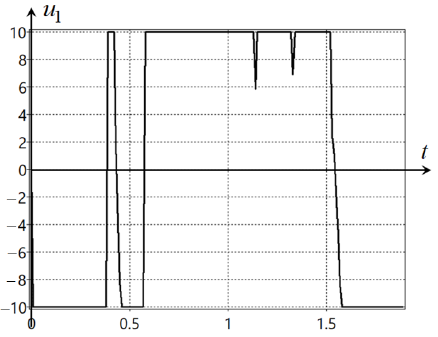
Figure A7. Plot of optimal values of control component u 1 .